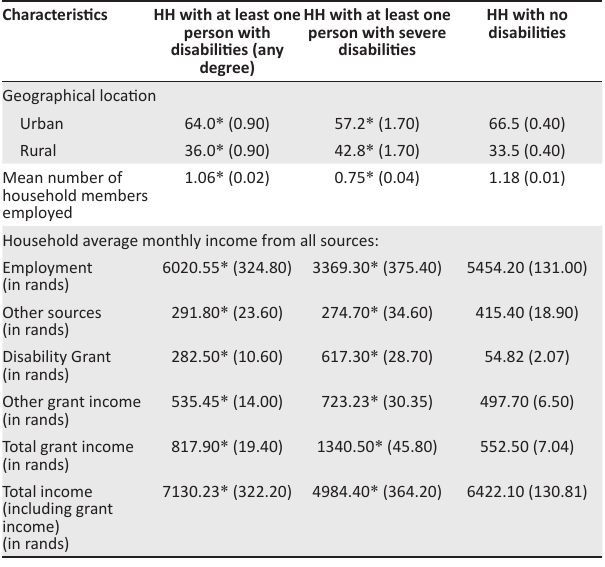
TABLE 4: Household